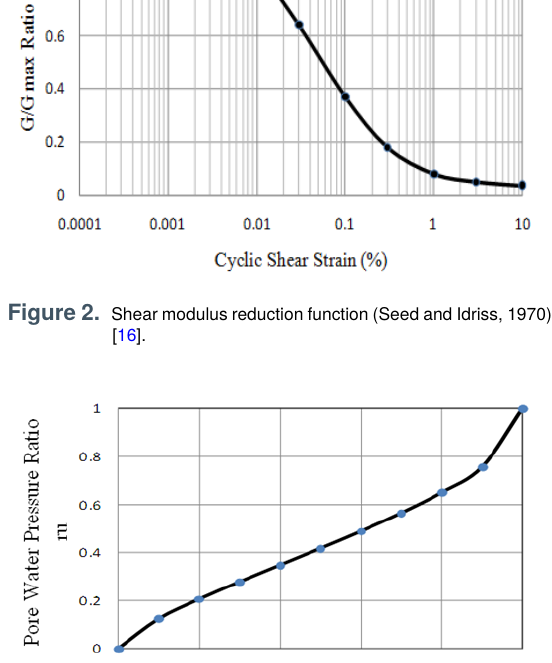
The harmonic load is applied at the surface as shown in Figure 1. The load is changed to different values by con- sidering different values of frequency; 5, 10, 25 and 50 rad/sec. with damping ratio equals 0.05 and the load amplitude equals 10 kN. The results are presented in figures which include; vertical displacement, pore water pressure, surface displacement and liquefaction zones, for loose, medium and dense sandy